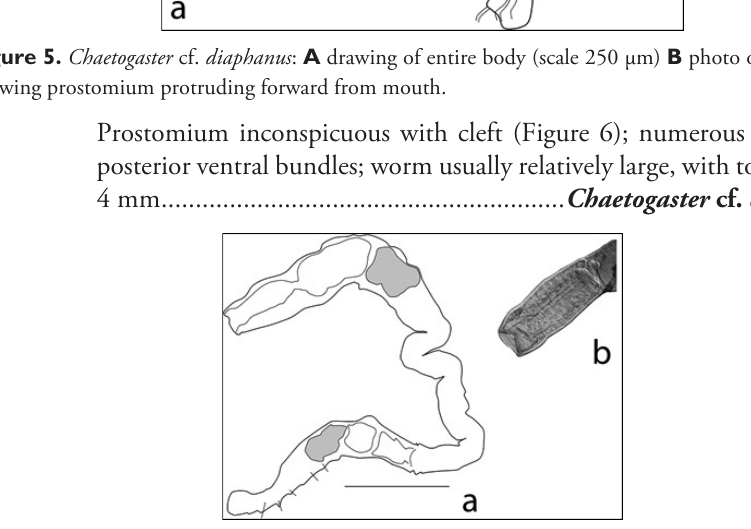
Figure 6. Chaetogaster cf. crystallinus : A outline drawing of entire body showing positions of chaetae that are limited to only ventral bundels of segments (scale 1 mm) B photo of anterior end showing cleft in